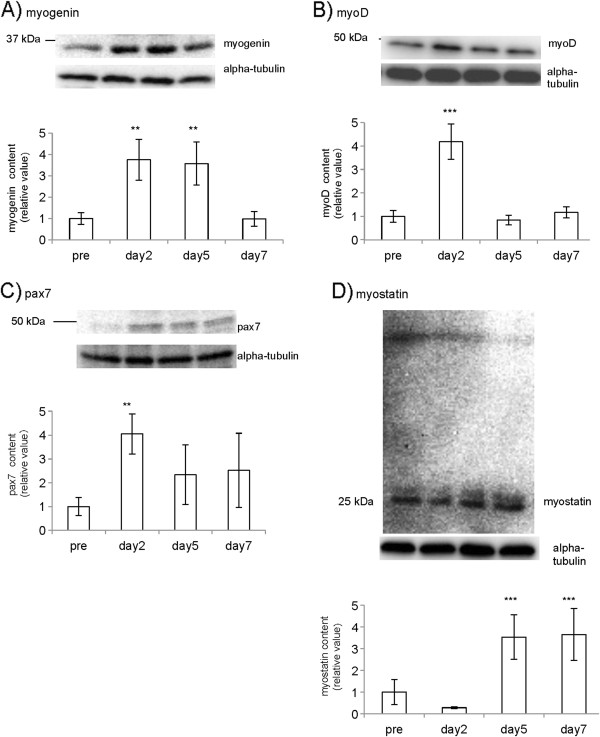
Muscle contents of myogenin, myoD, pax7, and myostatin as determined by Western blotting. The expression of myogenin before and after LC-induced muscle injury was examined. Obtained bands and their quantifications are shown (A). The expression of myoD (B), pax7 (C), myostatin (D) were also examined. Details are described in the materials and methods section. **: p < 0.01, ***: p < 0.001, compared to pre-treatment levels. Values are means and SDs.